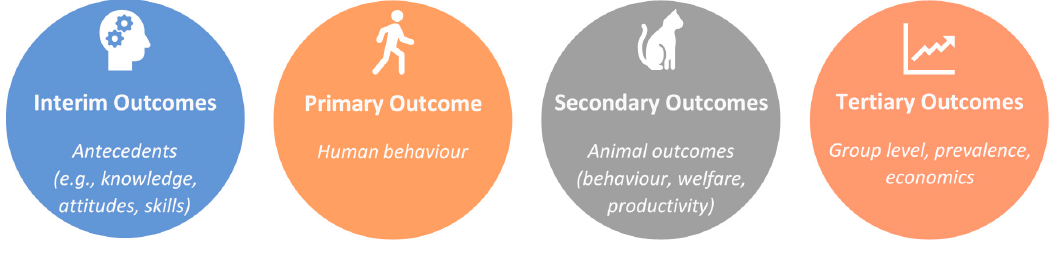
Figure 2. Levels of evaluation.